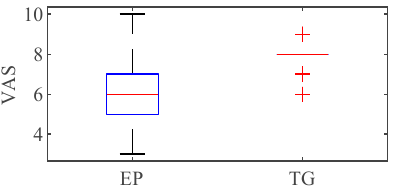
Figure 7. Comparison of Visual analog scale (VAS) between EP and TG stimulation.